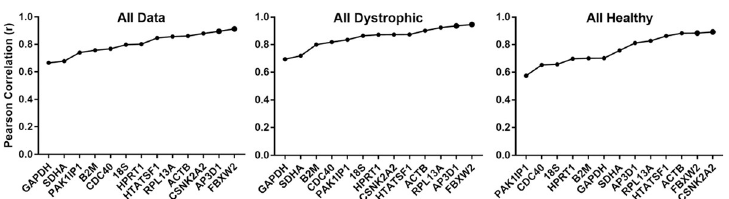
Fig 3. BestKeeper analysis. Representative outputs of the BestKeeper algorithm. Coefficient of correlation values for the reference gene candidates are shown for the entire dataset, or dystrophic or healthy samples alone (as indicated), ranked (left to right) from least stable to most